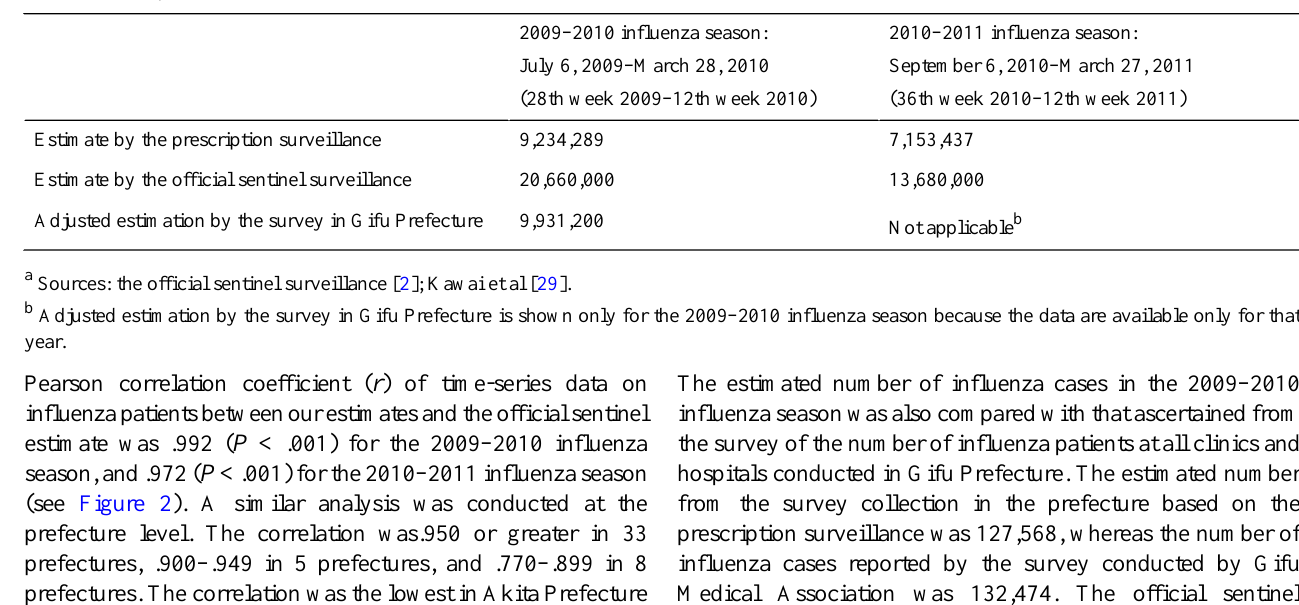
Table 1. Number of influenza cases estimated by the prescription surveillance, the official sentinel surveillance, and the Gifu Medical Association in